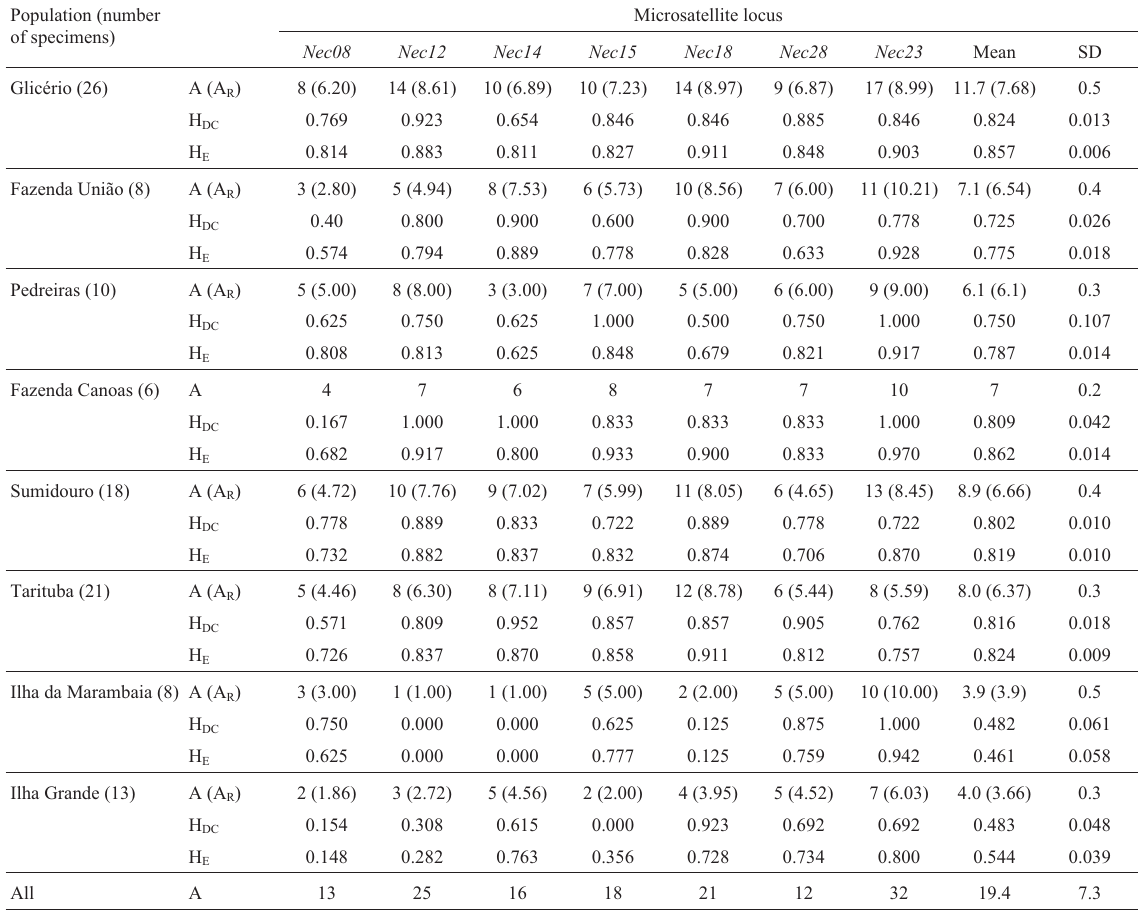
Table 1 - Genetic diversity of Nectomys squamipes populations. Population (number of